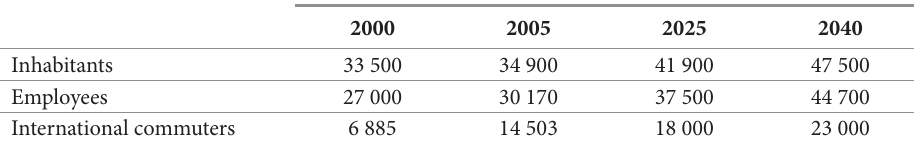
Table 1. Development of the population and employment in Liechtenstein 2000–2040 (Strittmatter Partner AG 2000)